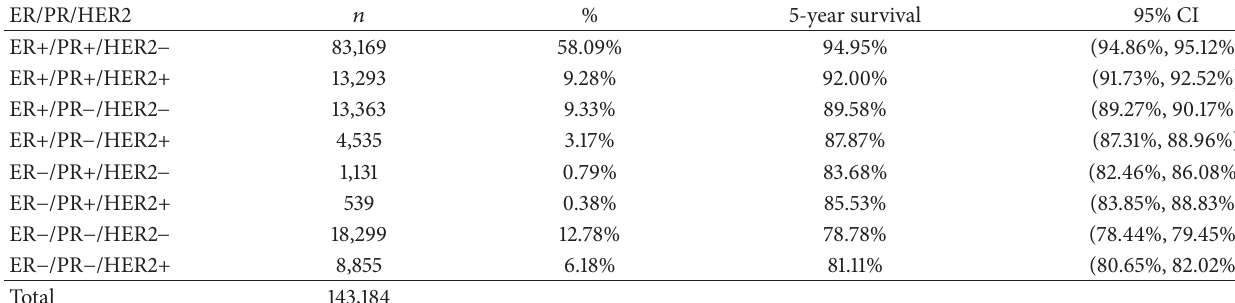
Table 2: Five-year survival of the eight ER/PR/HER2 subtypes ∗ .